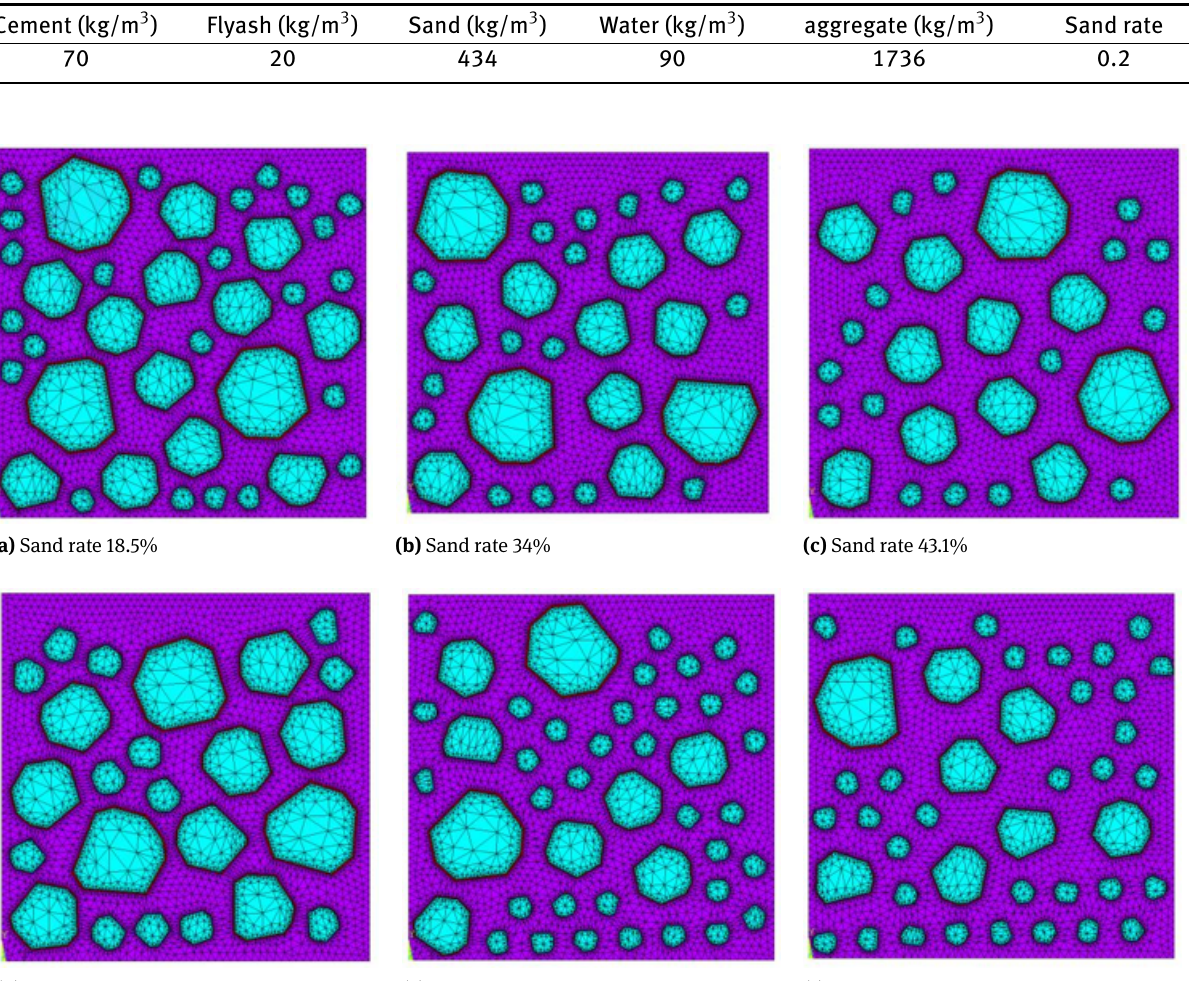
of large particle size was reduced under the condition that the total number of aggregates kept unchanged. The mod- els were shown in Figure 3 (e,